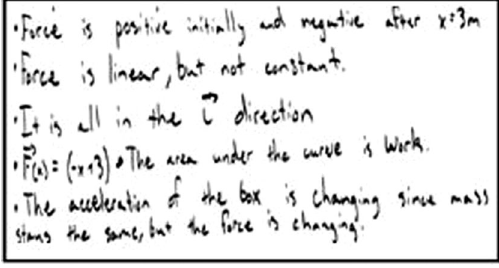
FIG. 20. Interpretation of force-position graph (question 7).